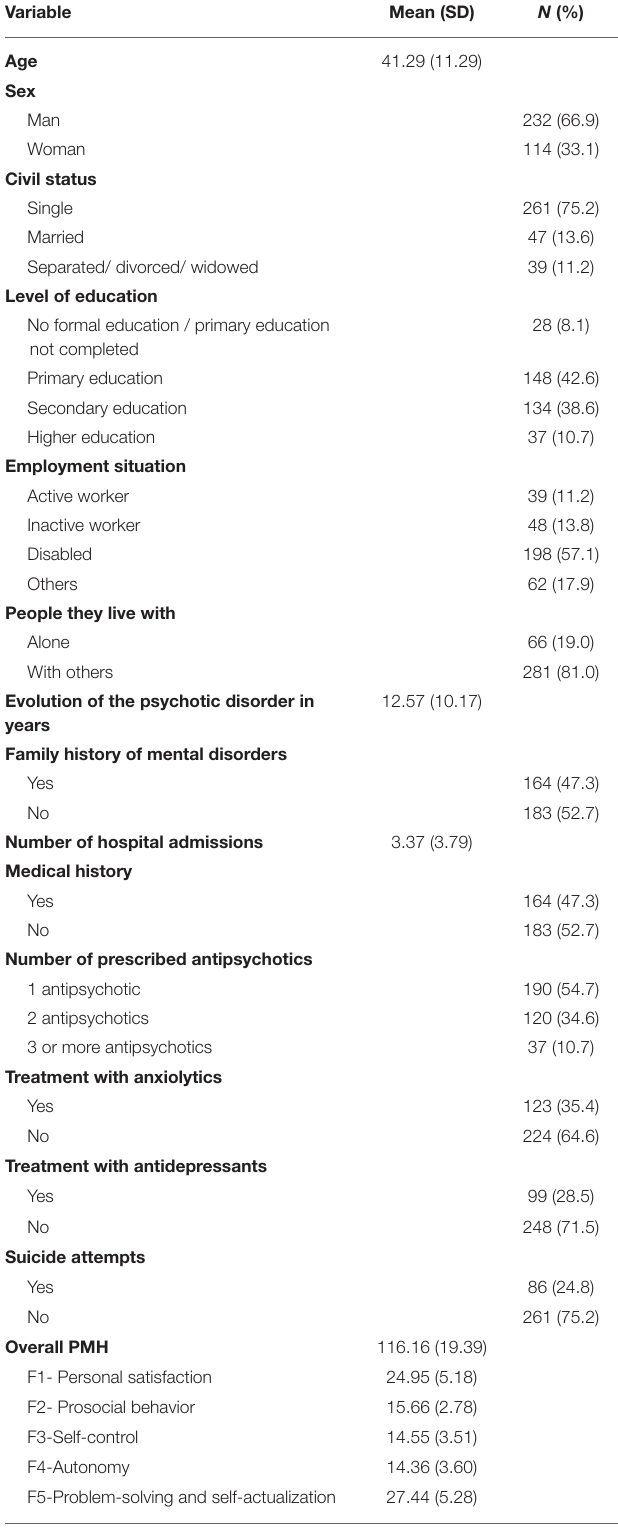
TABLE 1 | Sociodemographic and clinical characteristics, PMH on a global level and by factors, recovery, SWB, insight and functioning ( N = 347).